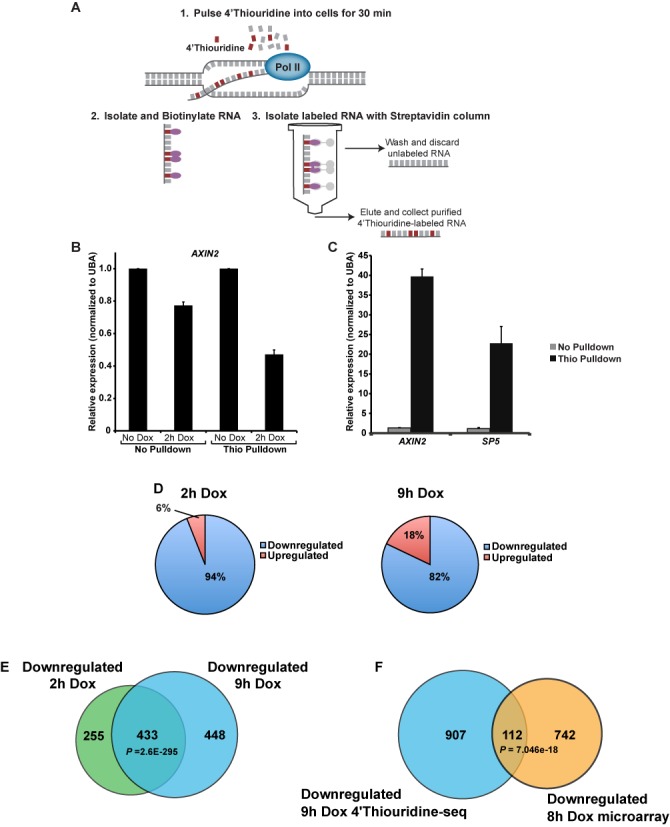
4′Thiouridine-seq identifies genes repressed by dnTCF1EWT. (A) 4′Thiouridine-seq involves addition of 4′Thiouridine into cells for 30 min to label nascent RNA transcripts. 4′Thiouridine-labeled RNA is isolated and sequenced, allowing for snapshots of transcription at any given time point of dnTCF1EWT induction. (B) Comparison of AXIN2 levels as assessed by normal RT-PCR (before pulldown) versus 4′Thiouridine-RT-PCR (same sample after pulldown), n = 3. Pulldown of 4′Thiouridine-incorporated transcripts causes a more dramatic decrease in AXIN2 in response to dnTCF1E WT induction to be detected (n = 3). (C) Wnt target genes are greatly enriched after 4′Thiouridine pulldown when compared to the housekeeping gene UBA as assessed by RT-PCR. (D) The majority of genes that changed expression after 2 h of dnTCF1EWT induction (P < 0.02) and 9 h of dnTCF1EWT induction (P < 0.012) were downregulated. (E) The overlap of genes downregulated at 2 h post-induction and 9 h post-induction was highly significant (P-value denotes the result of a hypergeometric test). (F) The overlap of genes downregulated at 9 h post-induction in the 4′Thiouridine-seq and at 8 h post-induction in a previous microarray experiment in a different clonal DLD-1 cell line was highly significant (P-value denotes the result of a hypergeometric test).